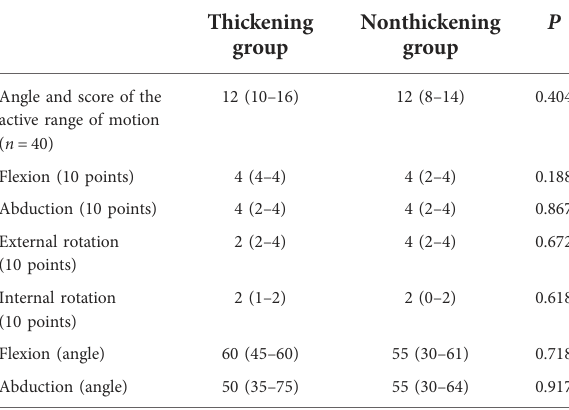
TABLE 5 Comparison of the improvements in the active range of motion between the thickening group and the nonthickening group before and after